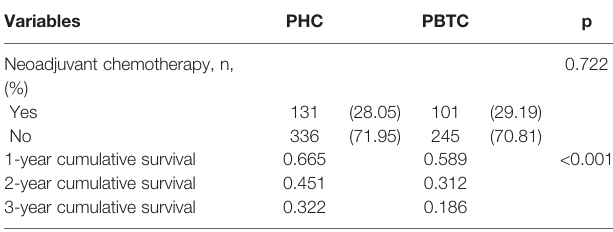
TABLE 1 | Baseline demographic and clinical characteristics of the